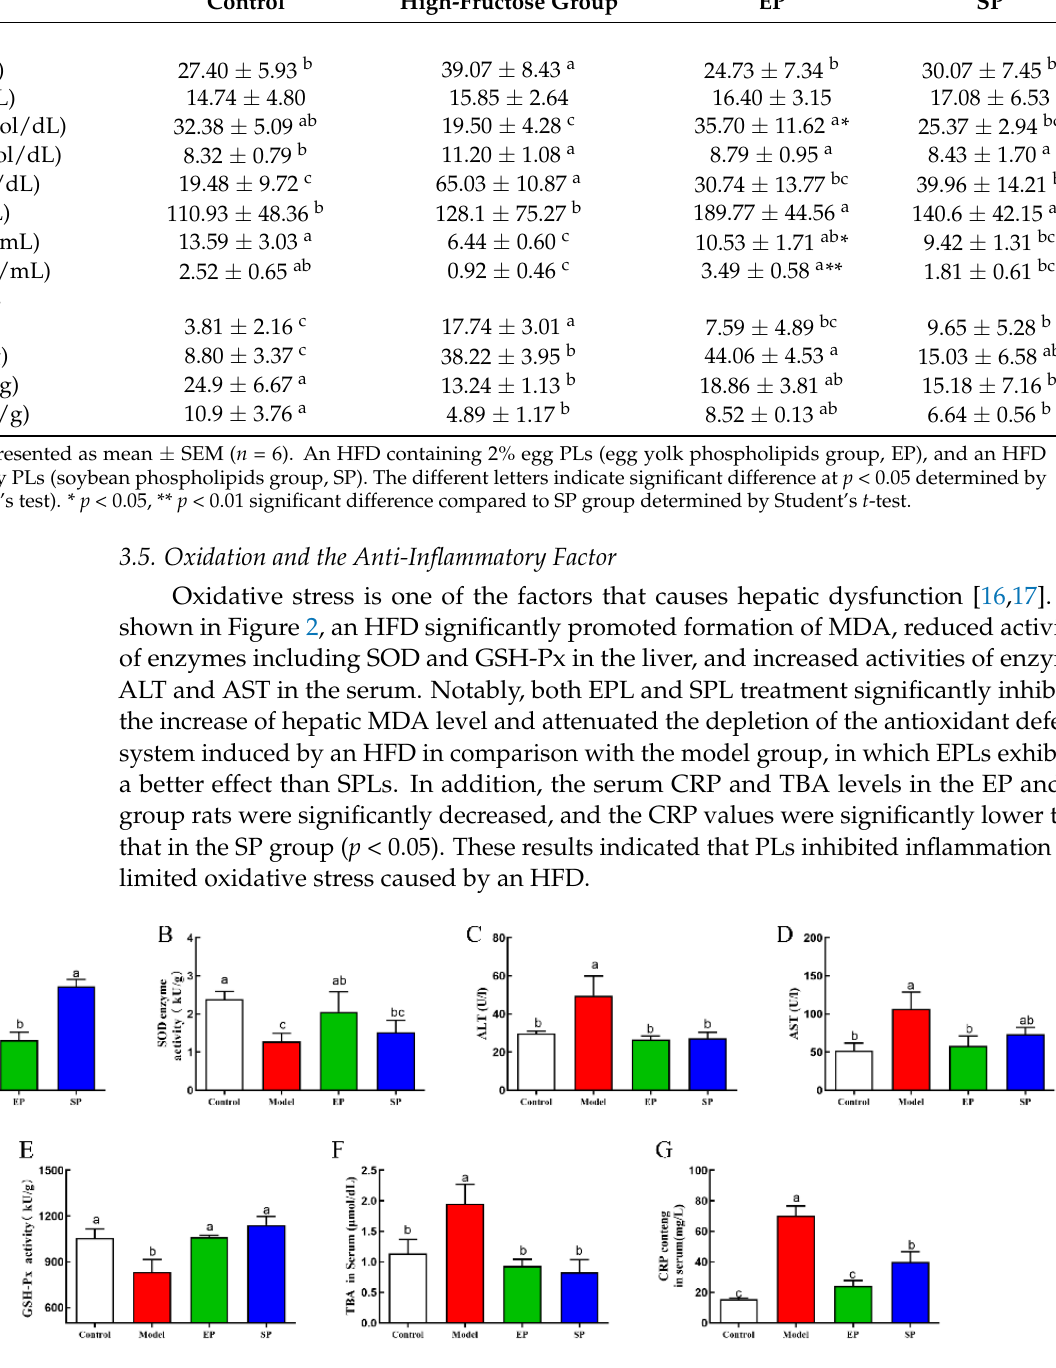
Figure 2. Effect of phospholipids on MDA, SOD, AST, ALT, NEFA, GSH-PX, TBA, and CRP. ( A ) MDA concentration in serum; ( B ) SOD enzyme activity in liver; ( C ) ALT enzyme activity in liver; ( D ) AST enzyme activity in serum; ( E ) GSH-Px enzyme activity in serum; ( F ) TBA concentration in serum; ( G ) CRP content in serum. An HFD containing 2% egg PLs (egg yolk phospholipids group, EP), and an HFD containing 2% soy PLs (soybean phospholipids group, SP). The different letters indicate significant difference at p < 0.05 determined by ANOVA (Duncan’s test).